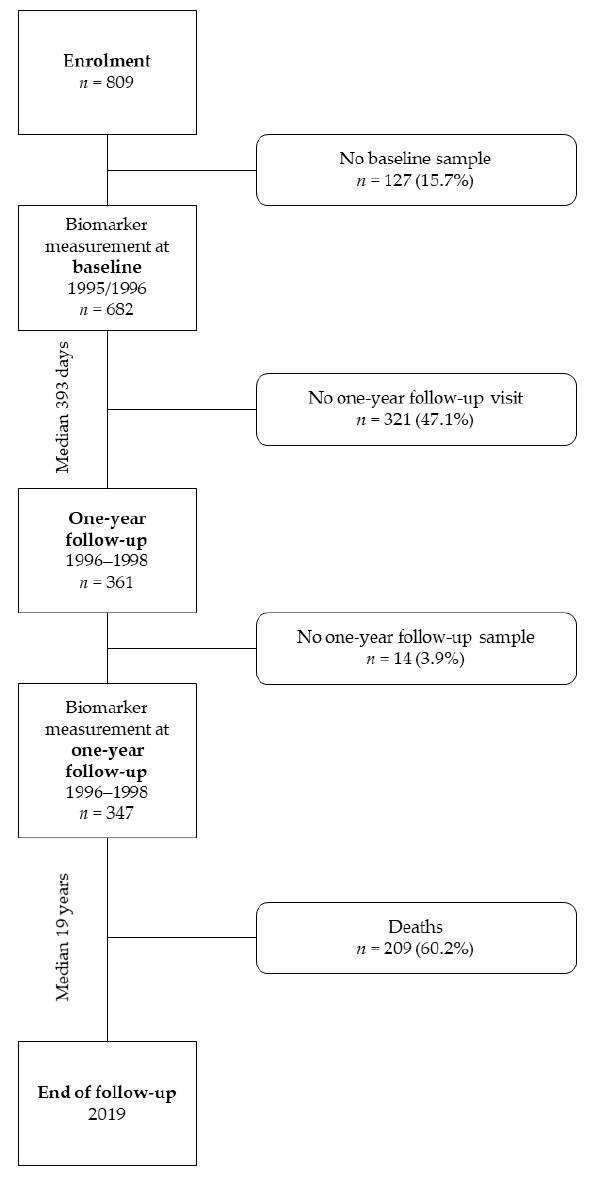
Figure 1. Study flow chart.